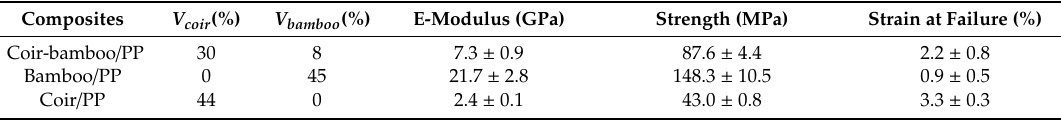
Table 2. Tensile properties of coir-bamboo / PP hybrid composite, and of mono bamboo / PP and coir / PP